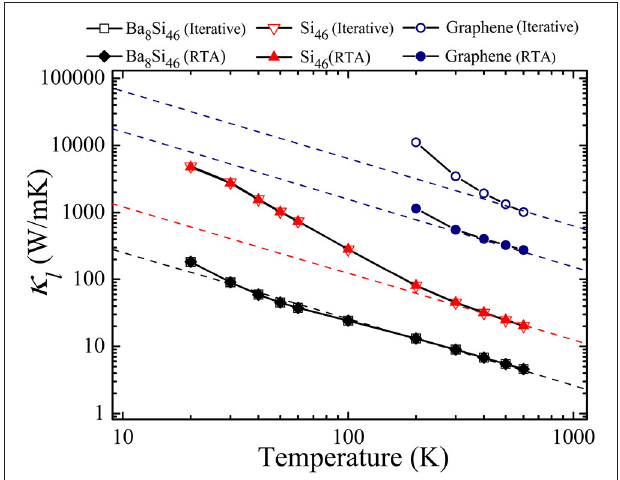
FIGURE 3 | The calculated κ l for Ba 8 Si 46 clathrate, host-only system Si 46 and graphene vs. temperature, respectively, from iterative solution (empty symbols) and RTA solution (filled symbols). The dashed lines show the corresponding 1/T temperature dependence.